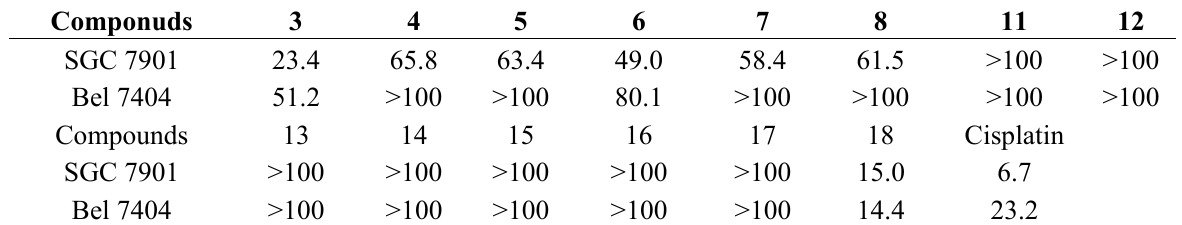
Table 1. In vitro antiproliferative activities (IC